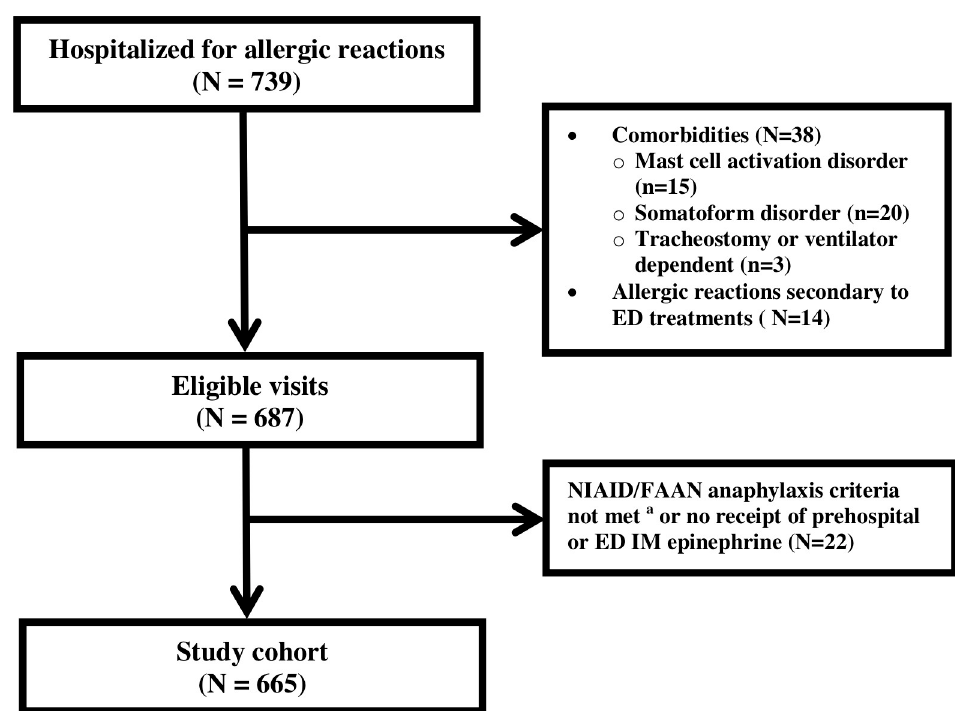
Fig 1. Patient flow diagram. a Manual chart review performed applying the 2006 National Institute of Allergy and Infectious Disease and the Food Allergy and Anaphylaxis Network diagnostic criteria for anaphylaxis [15].